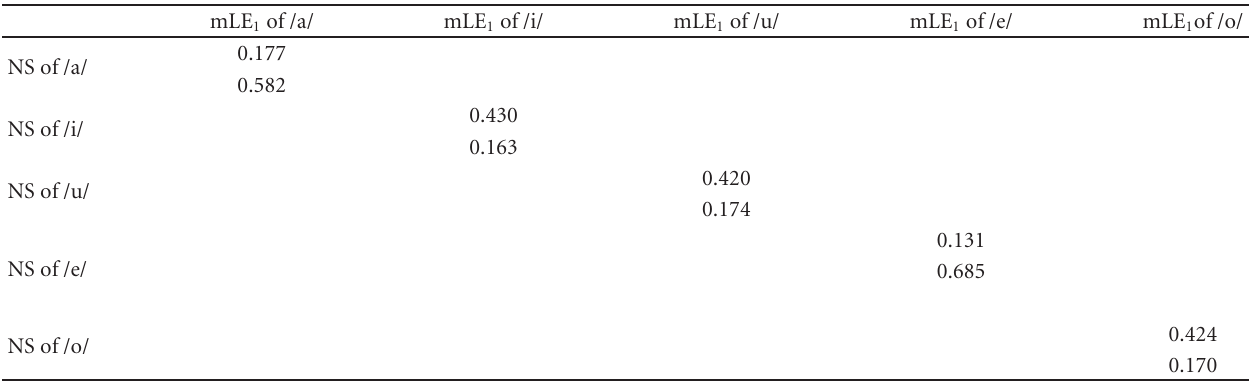
Table 4: Correlation coe ffi cients between the mLE 1 (mean of the first Lyapunov exponents) and NS (nasalance